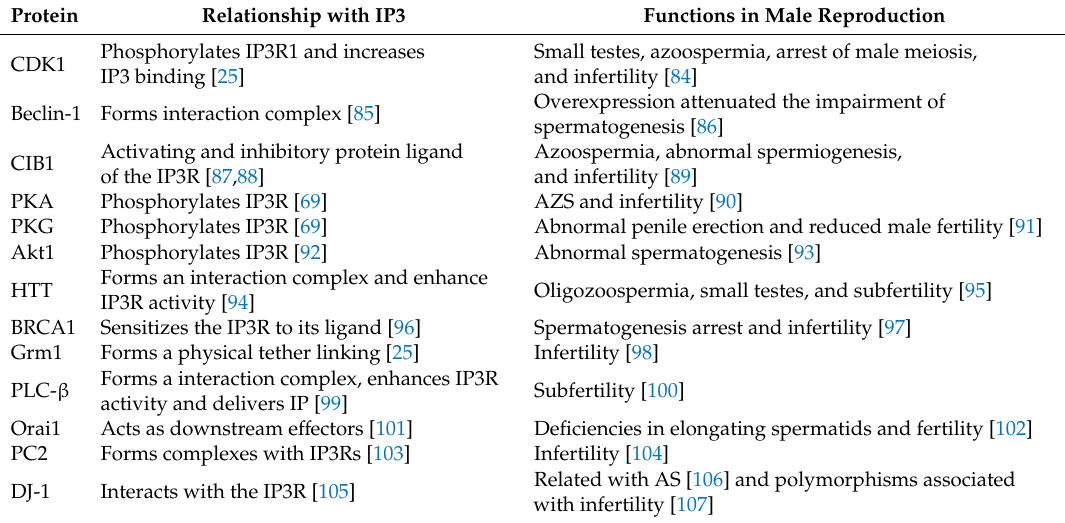
Table 1. E ff ect of inositol 1,4,5-trisphosphate receptor (IP3R) interaction proteins on male fertility. AZS,